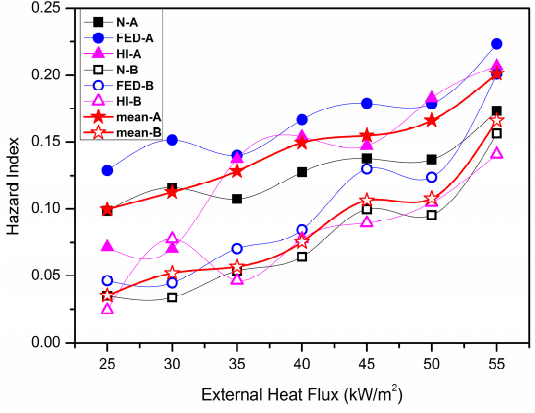
Figure 14. Fire hazard models for material A and B.